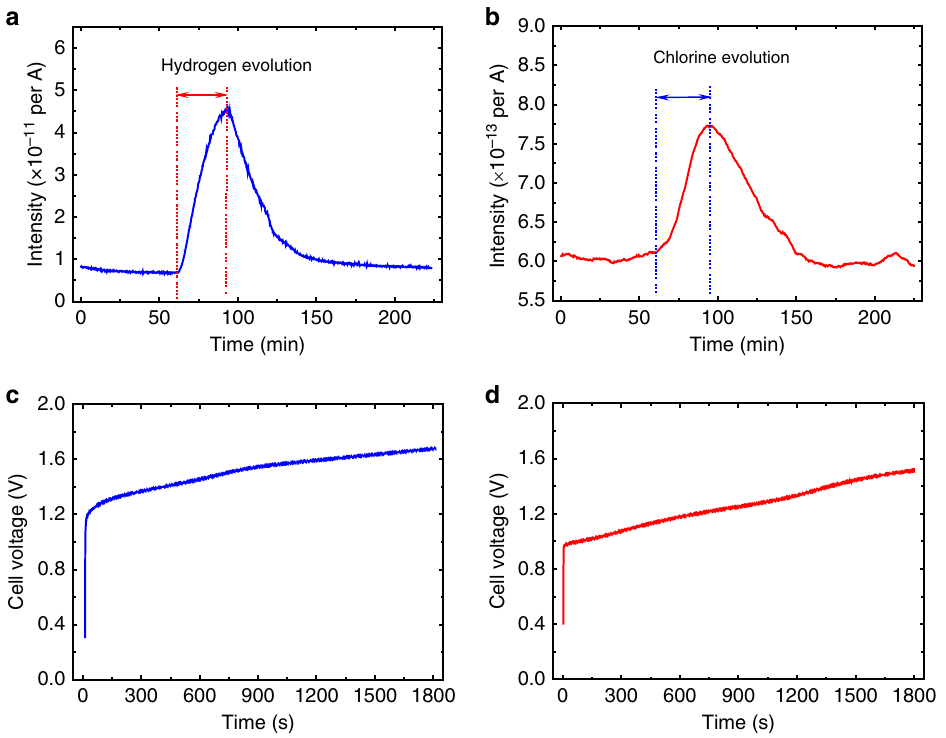
Fig. 4 In situ differential electrochemical mass spectrometry of H 2 and Cl 2 production. a DEMS curve of the H 2 evolution and the c corresponding chronopotentiometry curve (cell voltage vs. time) at an applied current of 100 mA. b DEMS curve of the Cl 2 evolution and the d corresponding chronopotentiometry curve (cell voltage vs. time) at an applied current of 100 mA. A pure Ar gas stream was used as the purge gas before the